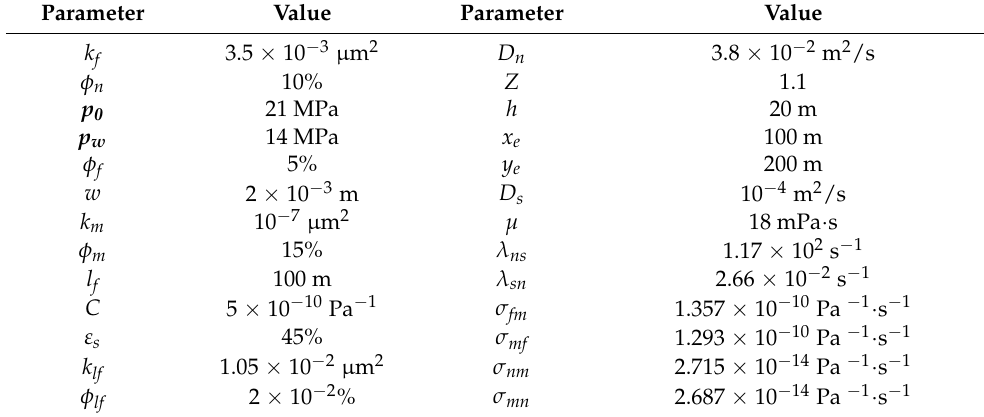
Table 1. Parameters of shale reservoirs [13,21,39] obtained from the Eagle Ford oilfield. Parameter